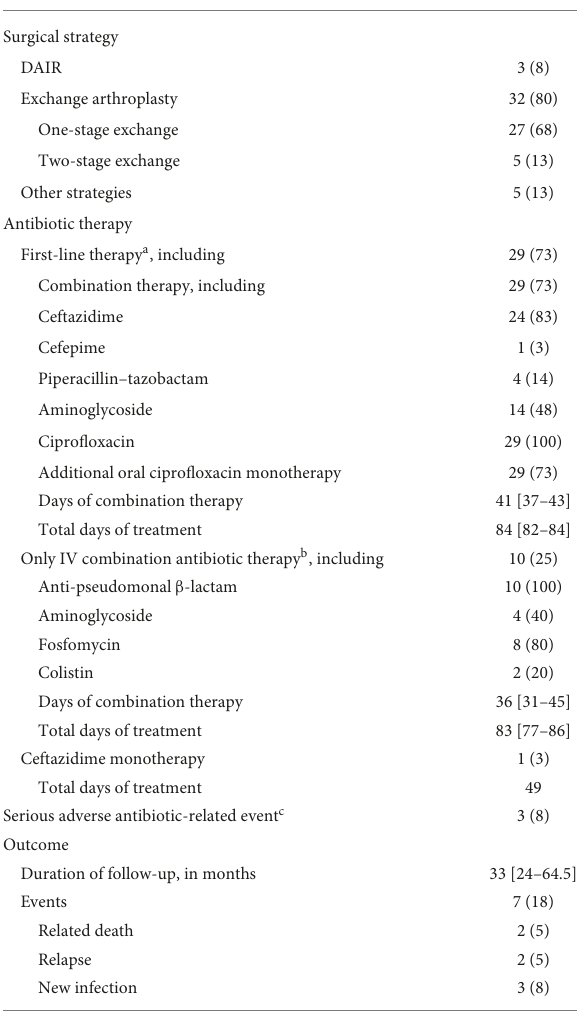
TABLE 2 Post-operative antibiotic therapies and outcomes of 40 P. aeruginosa PJIs after curative surgery.